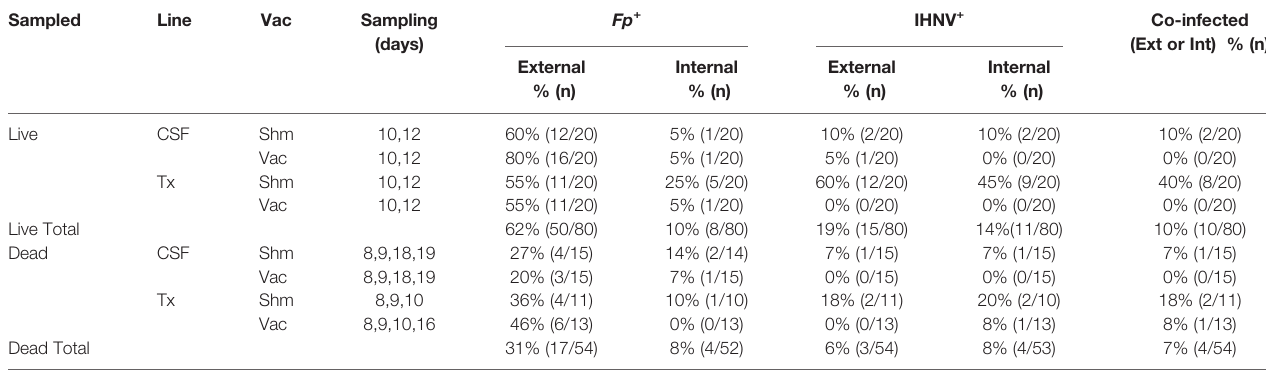
TABLE 4 | Frequency of fi sh positive for F. psychrophilum , IHNV, or co-infected with both pathogens, that had been removed from tanks alive, euthanized and sampled, or sampled after death in constant reuse water. Sampled Line